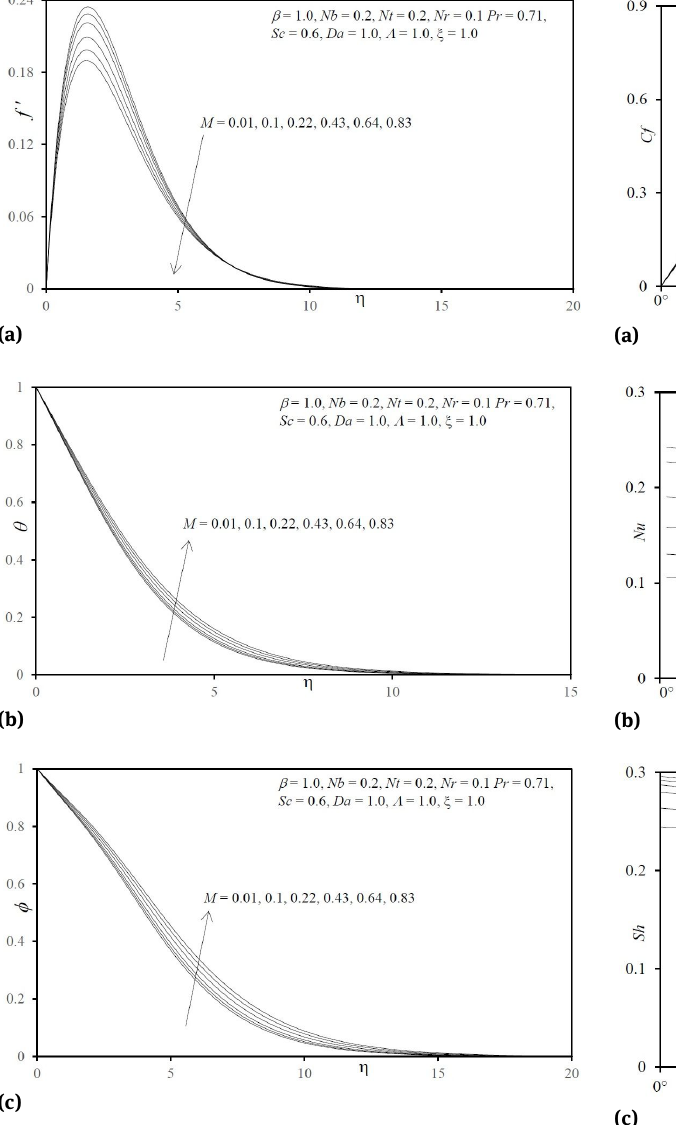
Fig. 9: (a) Influence of Nb on Skin Friction; (b) Influence of Nb on Nusselt Number; (c) Influence of Nb on Sherwood Number Figs. 7(a) – 7(c) presents the impact of Forchheimer pa- rameter, Λ on velocity ( f / ), temperature ( θ ) and concentra- tion ( φ ). The parameter Λ is associated with the second or- der Forchheimer resistance term, - ξΛ (cid:0) f (cid:48) (cid:1) 2 in the momen- tum equation. The Forchheimer drag is directly propor- tional to Λ . As shown in Fig. 7(a), the flow is markedly decelerated with increasing values of Λ . As indicated by Kaviany [63], the Forchheimer effects are associated with higher velocities in porous media transport. A significant elevation in both temperature and nano-particel species diffusion concentration is seen with an increase in